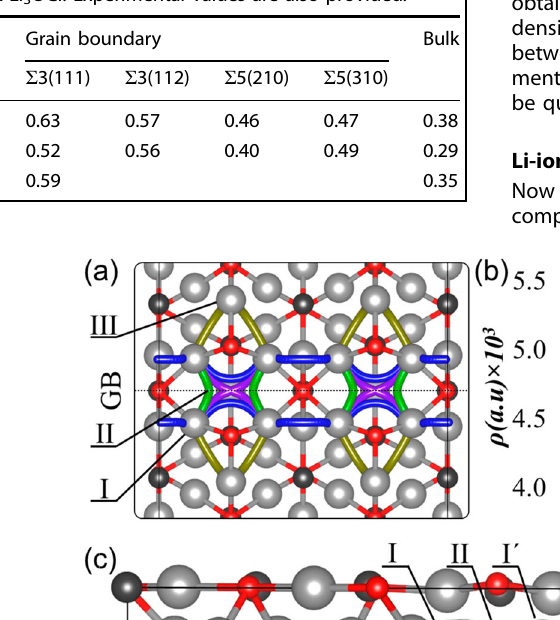
Table 1. Computed Li-ion migration energy barriers for different GBs models and bulk Li 3 OCl. Experimental values are also provided.